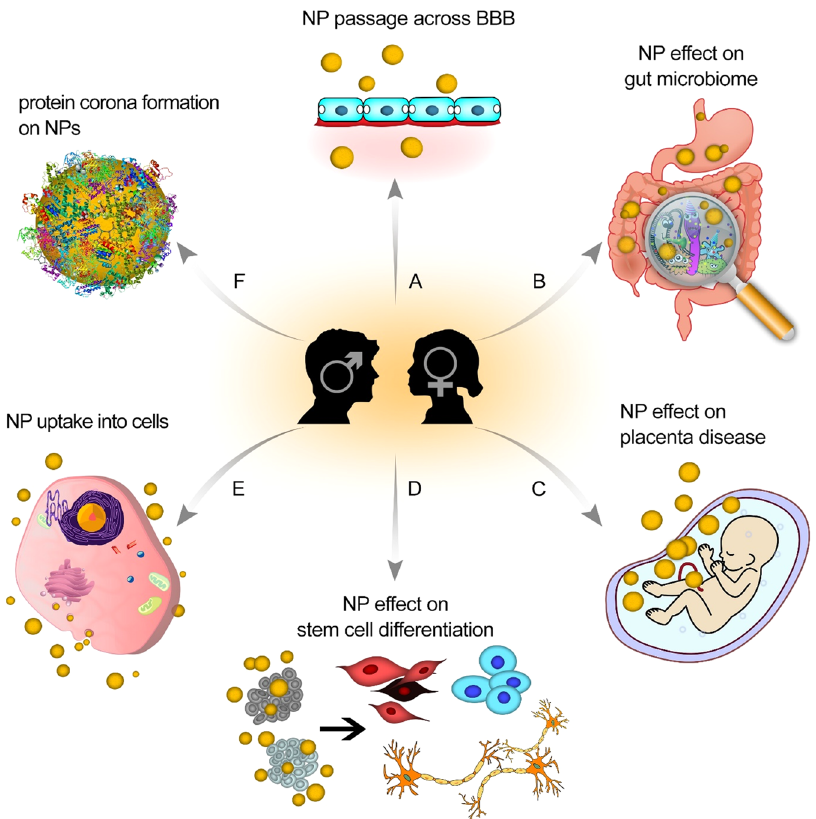
Fig. 3 Schematic representation of sex-dependent therapeutic/toxic effects of nanoparticles. A Crossing the blood – brain barrier, ( B ) gut microbiome composition, ( C ) placenta-related diseases, ( D ) stem cell differentiation, ( E ) uptake of NPs into cells, ( F ) formation of biomolecular/protein